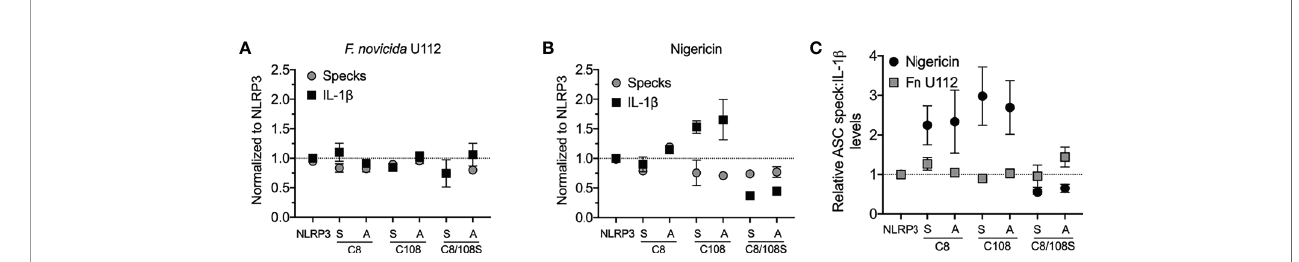
FIGURE 3 | N-terminal cysteine mutations uncouple speck formation and in fl ammasome function. (For ASC speck analysis) HEK293T cells were transfected with 50 ng of GFP-ASC with 100 ng NLRP3 or pcDNA3. Eighteen hours post-transfection, cells were either stimulated with nigericin agonists or left untreated, or 4 h after transfection, cells were infected with Francisella novicida ( Fn ). Cells were fi xed at 2 h after stimulation (nigericin) or 24 h post- Fn infection and analyzed for ASC specks by time-of- fl ight in fl ammasome evaluation (TOFIE). (For IL-1 b release) HEK293T cells were transfected with 8 ng of myc-ASC with 100 ng NLRP3 or pcDNA3, 40 ng CASP1, and 200 ng IL1B. Eighteen hours post-transfection, cells were either stimulated with indicated agonists or left untreated. (A) Normalized ASC speck frequency (TOFIE) in comparison with normalized IL-1 b release in reconstituted 293T cells following Fn U112 infection. (B) Normalized ASC speck frequency (TOFIE) in comparison with normalized IL-1 b release in reconstituted 293T cells following nigericin stimulation. (C) Comparison of the ratio of normalized ASC specks frequency (TOFIE) with normalized IL-1 b release following NLRP3 activation by nigericin stimulation and Fn